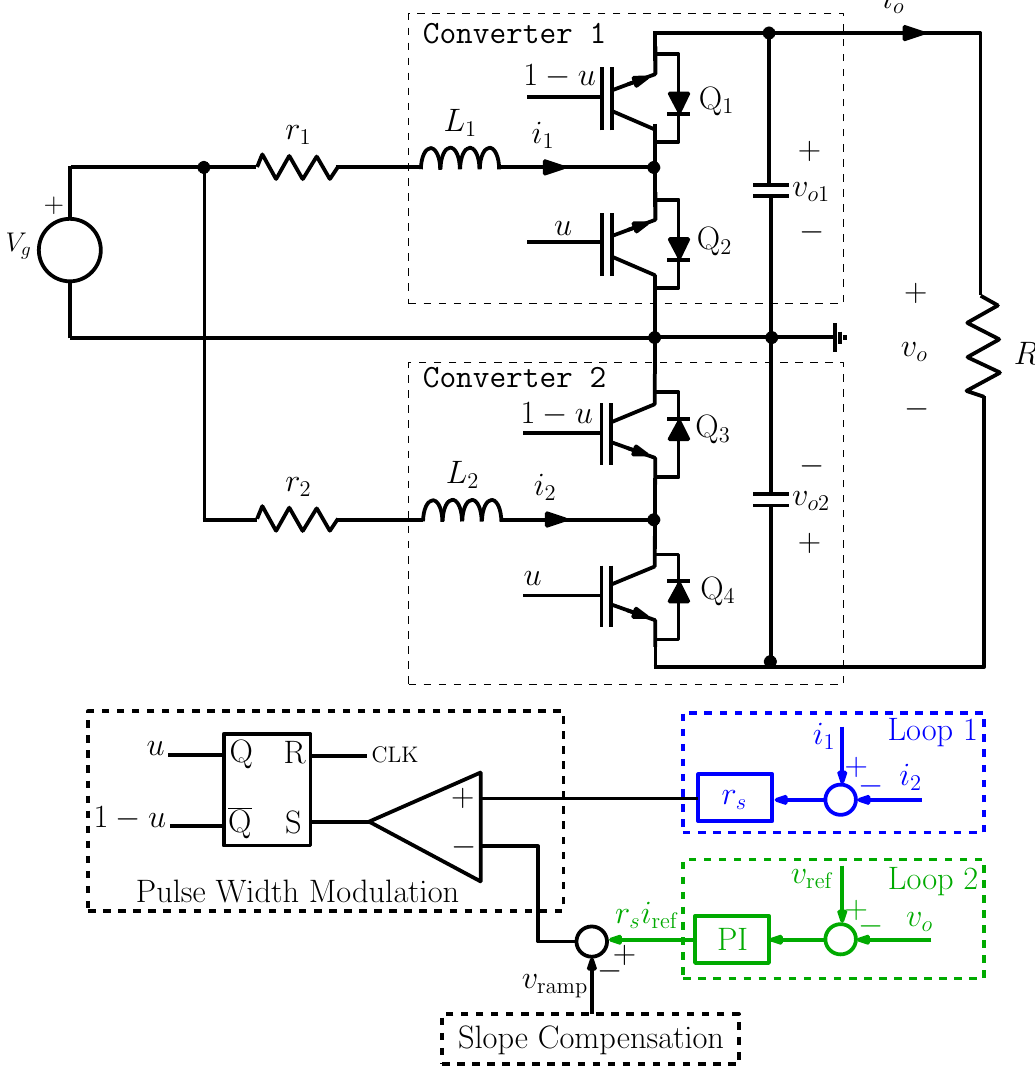
Figure 1. The differential boost inverter under two-loop